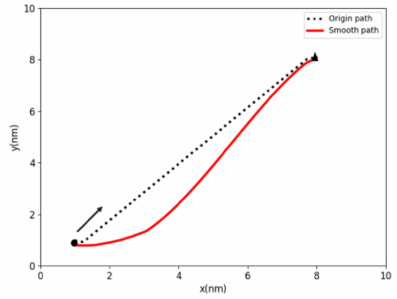
Figure 9. Path smoothing diagram.